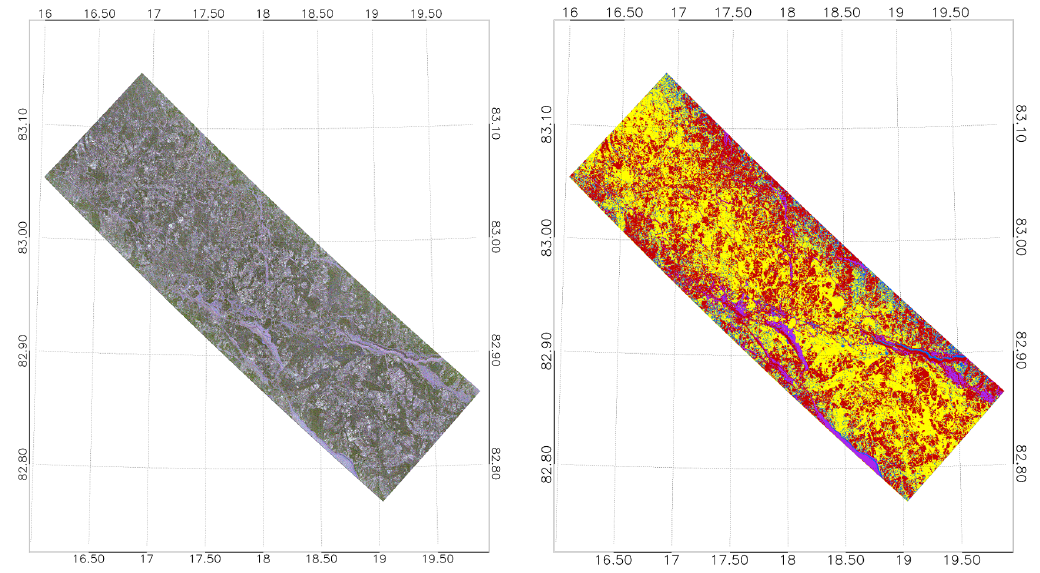
Figure A7. ( Left ) Geocoded Pauli RGB composite (Red: HH-VV Green: HV+VH Blue: HH+VV) of the TS-X acquisition on 23 April 2015, frame 2; ( Right ) ice classification. Blue: open water/nilas (OW), purple: young ice (YI), yellow: first year ice (SFYI), red: rough first year ice/multi-year ice